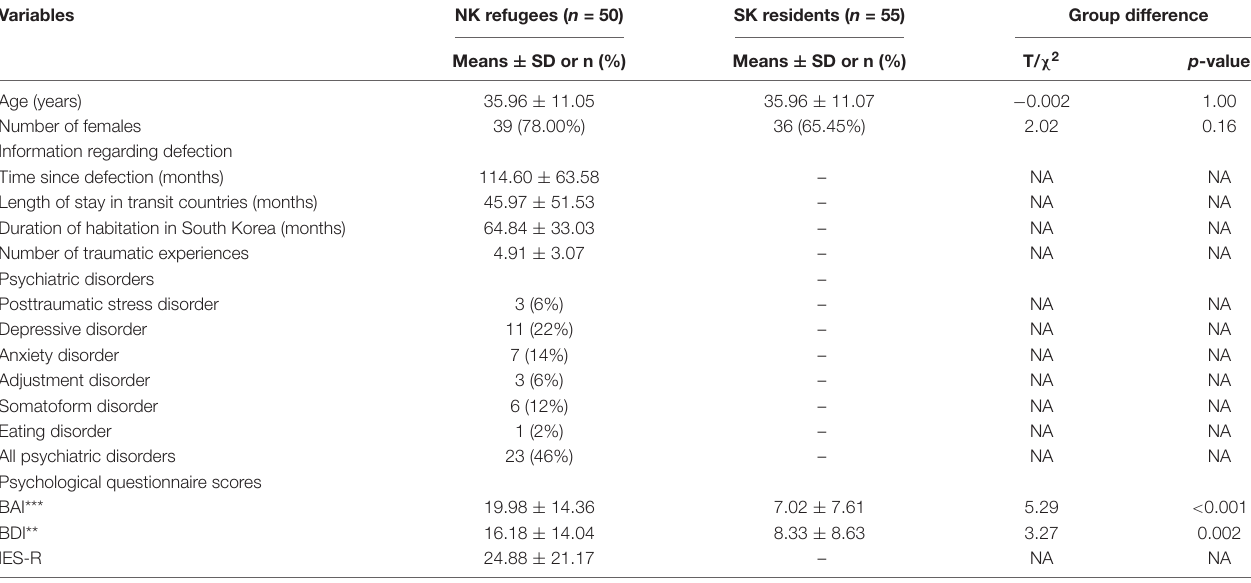
TABLE 1 | Demographic and clinical characteristics of North Korean (NK) refugees and South Korean (SK) residents.